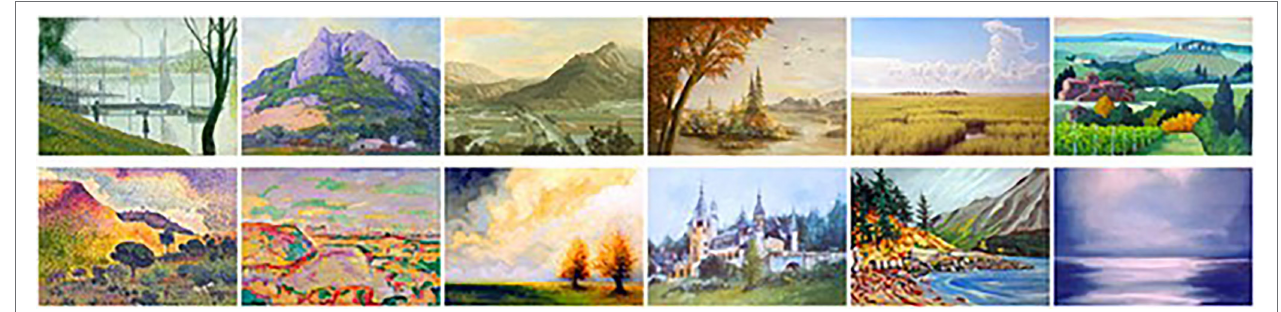
FIGURE 1 | Landscapes and skyscapes used in Experiment 1, reprinted from “Learning Concepts and Categories: Is Spacing the ‘Enemy of Induction?’” by Kornell and Bjork (2008). Copyright 2008 by Kornell. Reprinted with